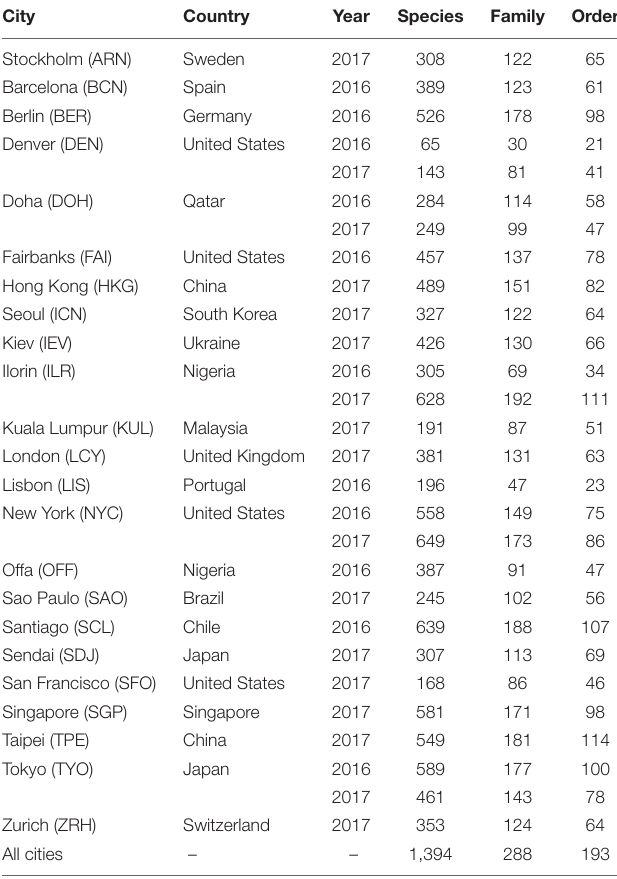
TABLE 1 | Details of the cities included in the main